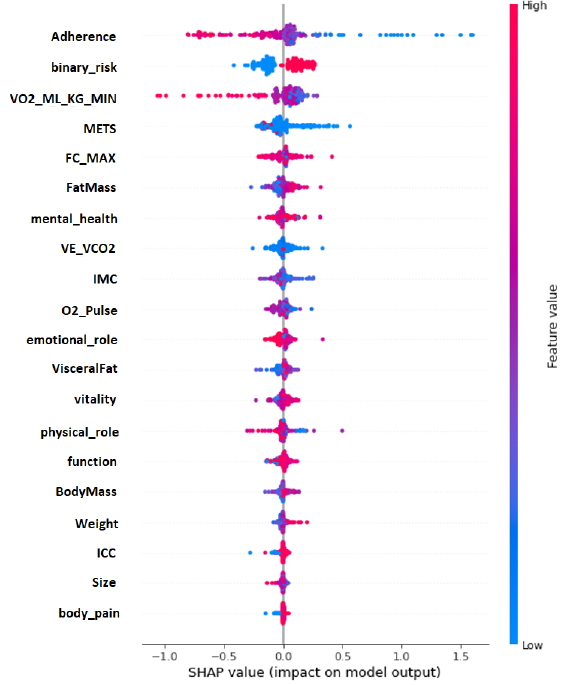
Figure 7. Impact distribution of the variables in the cardiovascular risk